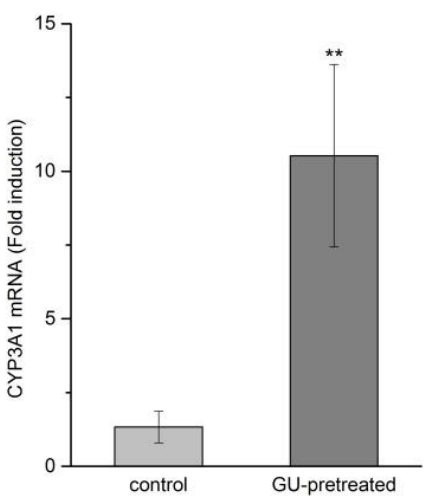
Figure 6. Effect of GU on the induction of CYP3A1 mRNA expression (n = 5). Data are expressed as mean ± SD. ** p < 0.05 compared with the control group.